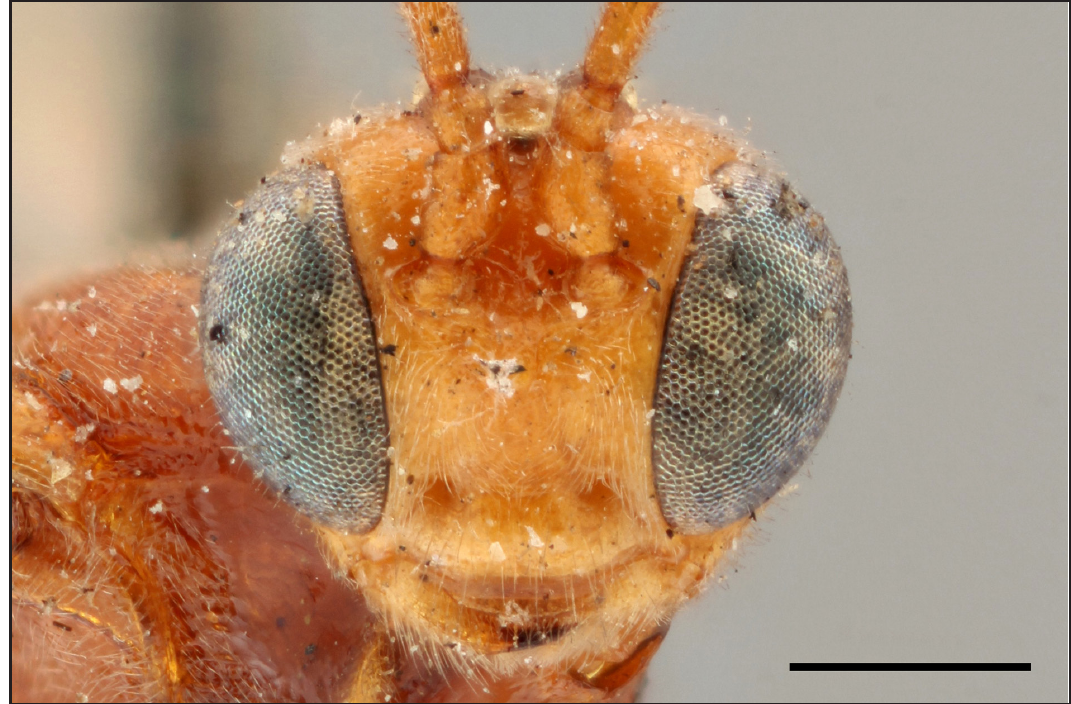
Fig. 2.5. Detail of pinned insect image. Frontal view of a specimen of Bracon chrysophthalmus at 5× magnification. Scale = 500